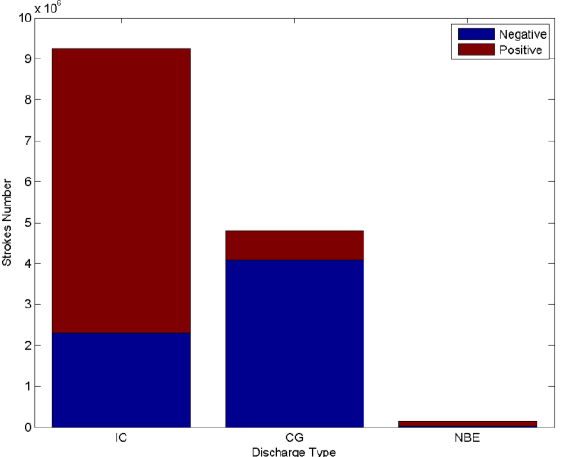
Figure 11. The proportions of different types of lightning in 2014.